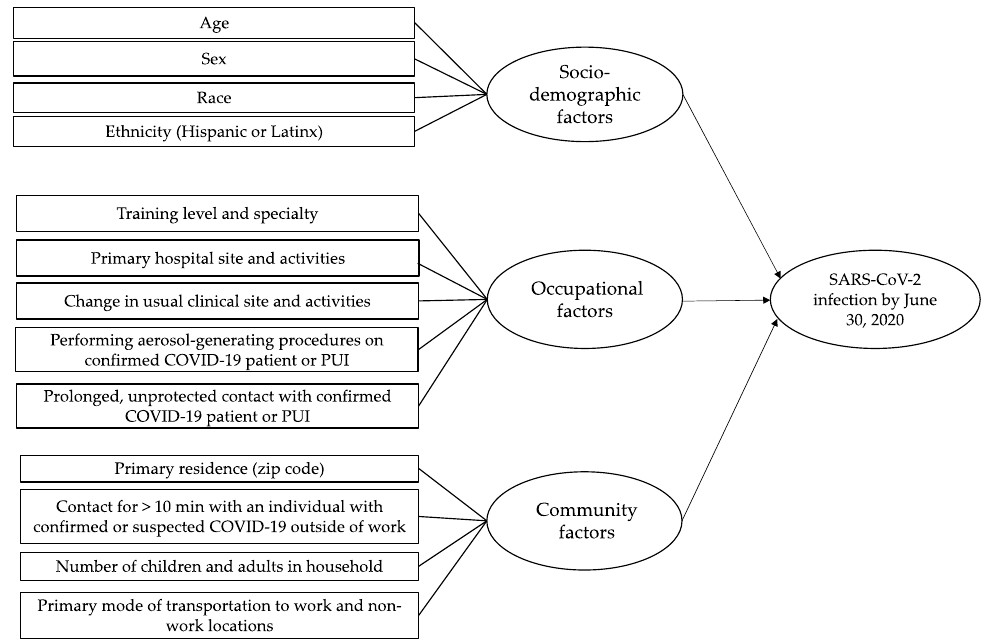
Figure 1. Flow chart of participant recruitment and survey responses.